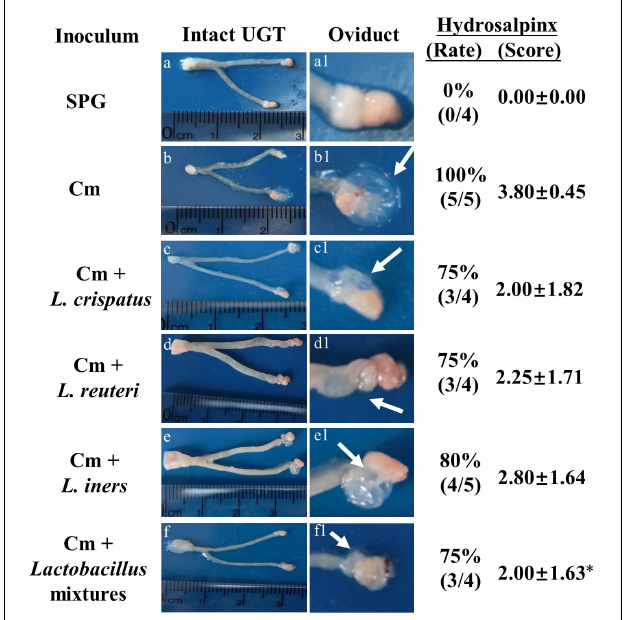
FIGURE 5 | Detecting gross genital tract pathology from lactobacillus intravaginally administrated mice following intravaginal infection with C. muridarum . Groups of female BALB/c mice ( n = 5) intravaginally inoculated with different lactobacilli as described in the Figure 3 legend. On Day 80 after infection, all the mice were sacrificed for genital tissue pathology evaluation. One representative overall appearance of the entire upper genital tract was displayed on the left column (a-f) , while the magnified images of the oviduct on the (a1–f1) , with the corresponding hydrosalpinx marked with white arrows. The corresponding hydrosalpinx incidence rate (Chi-square test) and severity scores were given on the right column. ∗ p < 0.05 vs. the Cm group (one-way